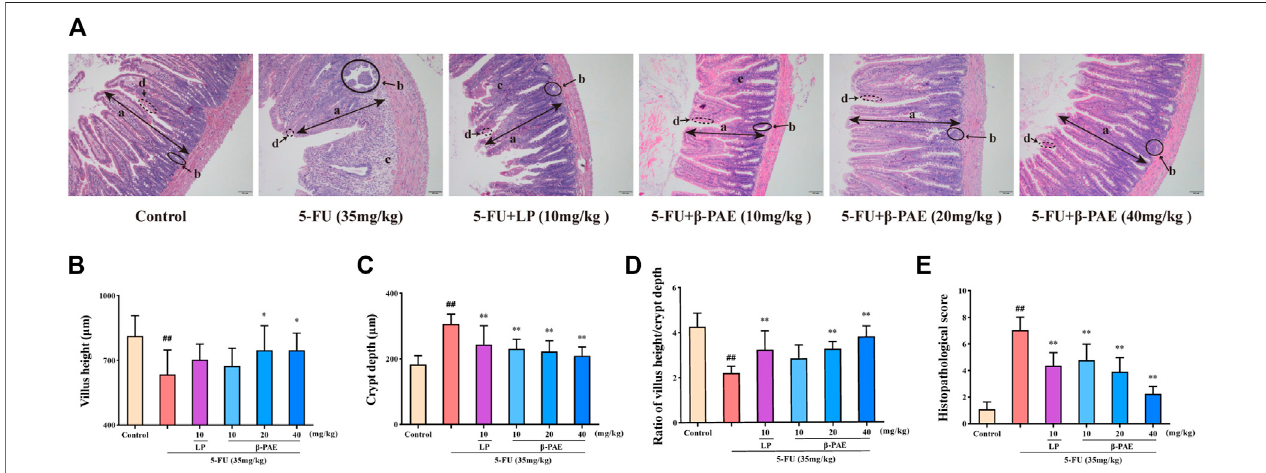
FIGURE 4 | Effects of β -PAE on small intestinal histopathology. (A) Small intestine sections showed by H&E staining (magni fi cation 100x), the symbols are as follows:(a)villus;(b)cryptlumen;(c)in fi ltrationarea;(d)microvillus; (B) Villusheight; (C) Cryptdepth; (D) Ratioofvillusheight/cryptdepth; (E) Thehistopathologicalscore of small intestine H&E staining. Data are shown as mean ± SD ( n (cid:2) 6). # p < 0.05, ## p < 0.01 versus control group; * p < 0.05, ** p < 0.01 versus 5-FU group.